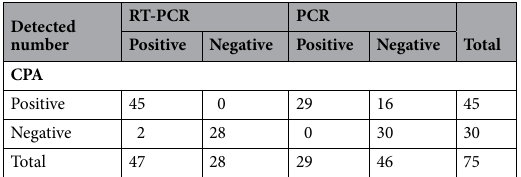
Table S1. Among the 75 samples with 0.1 ≤ S/P ≤ 0.2, the positive rates for CPA, RT-PCR and PCR were 60.0% (45/75), 62.6% (47/75) and 38.7% (29/75), respectively. And the 45 samples that tested ALV-J positive by CPA were included in the 47 samples tested positive for RT-PCR. Detailed results are shown in Table 3 and Supple- mentary Table S2. The sensitivity of the ALV-J CPA assay was higher than that of conventional PCR, which was comparable with RT-PCR. Among a total of 123 cell cultures which inoculated with clinical plasma, 71 samples tested positive for CPA and 73 samples tested positive for RT-PCR, and the 71 samples tested positive for CPA were included in the 73 samples tested positive for RT-PCR, so the coincidence rate of the two methods was 97.3% (71/73).